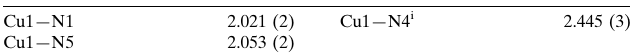
Selected bond lengths (A˚ ).